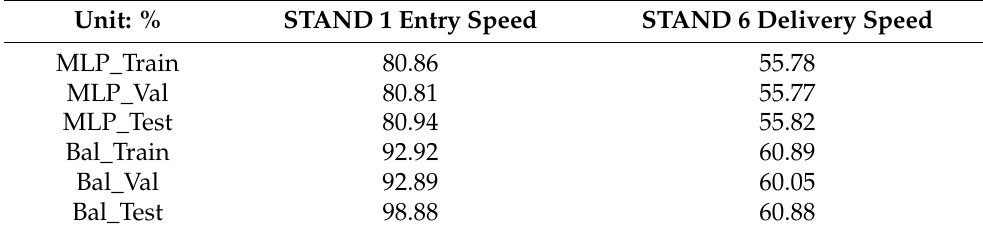
Table 21. Comparison of the usage rates of the speed. Unit: %